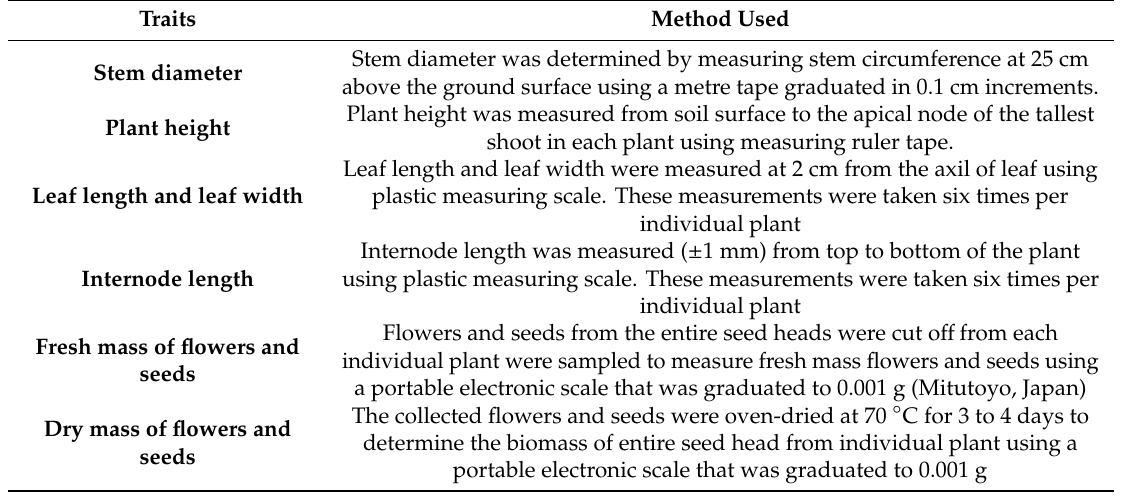
Table 7. Traits measured and methods that were used in a study aimed at investigating the phenotypic and genetic diversity of P. australis in Kashmir and Quebec.